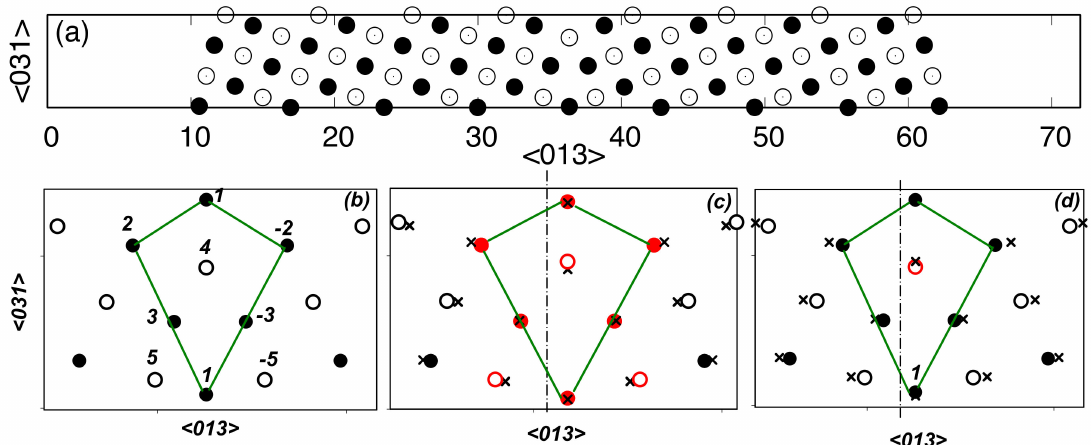
Figure 1. The (100) plane projection of a bicrystal containing a symmetric Σ 5{013} <100> tilt grain boundary (GB) ( a ). Both the atomic cell and the vacuum layer are shown; numbers indicate distances in Angstroms. Open and closed circles correspond to atoms in the two nearest (100) planes. Structural units characterizing the local atomic configuration [36] are marked with solid lines for Al ( b ), Al-Zn ( c ), and Al-Mg ( d ) alloys. Dash-dotted lines show the position of the planes, parallel to the GB plane, along which the shear or cleavage of the bicrystal was performed. Red circles correspond to impurity atoms; crosses mark the positions of atoms before